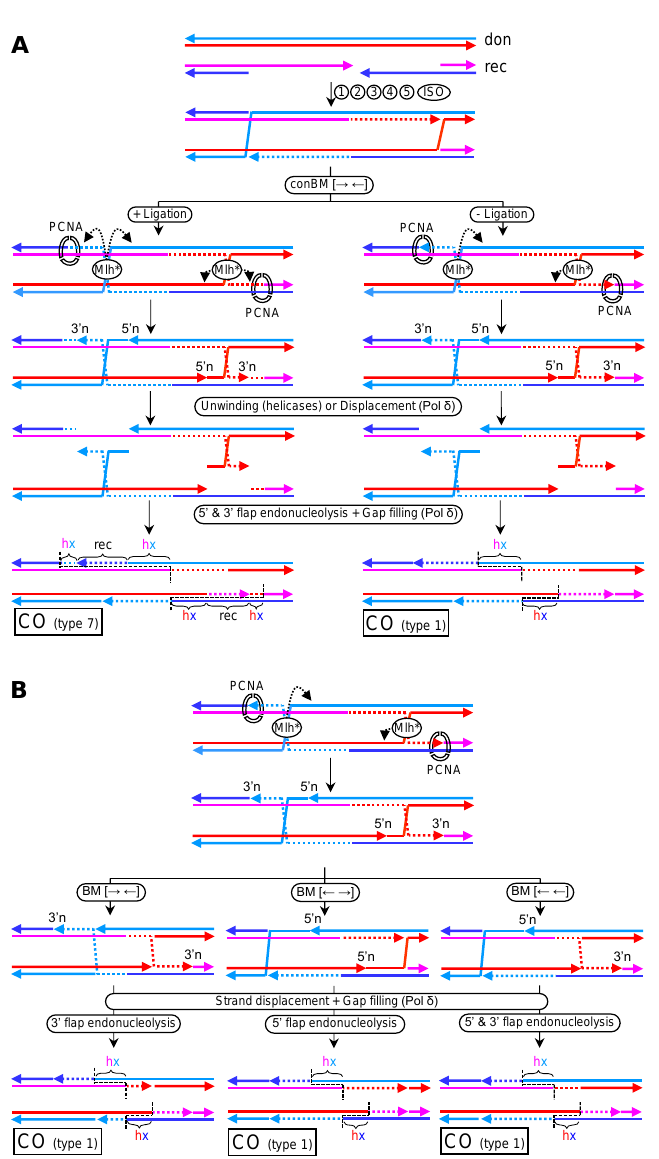
Figure 11. Models for ZMM meiotic resolution based on Mlh1-Mlh3 making incisions in cis upon a DPO dHJ. ( A ) Models in which cHJs are resolved from flanking nicks in the crossover strands. Steps 1–5 and ISO are like in Figure 10. Then, convergent branch migration is needed to relocate the newly synthesized tracts within the cross-joins, so that PCNA directs incisions into the crossover strands. Several mechanisms can then process each cHJ from the new nick located 5 (cid:48) to the cHJ (5 (cid:48) n). To ease visualization, two steps are depicted. Firstly, the unwinding and separation of the portion of nicked crossover strands that stretched across the cHJ, which resolves the cHJ into a 5 (cid:48) -flap and a 3 (cid:48) -flap. This can be achieved by the concerted actions of 3 (cid:48) → 5 (cid:48) and 5 (cid:48) → 3 (cid:48) helicases, or the displacement activity of Pol δ . Secondly, the resulting ssDNA gap is filled in by Pol δ , and the flaps are removed by specialized flap endonucleases. Note that strand displacement and gap filling occur in a single step when Pol δ commences resolution. If a DPO dcHJ is the substrate (left branch; + ligation), a double incision per cHJ is required. Because of the polarity of PCNA, the incision located 3 (cid:48) to the cHJ (3 (cid:48) n) ought to occur within the newly synthesized track. Thus, the genetic outcome is a reciprocal CO with a hx-recipient-hx tract (type 7). If a DPO dnHJ was the substrate before the converging migration (right branch; -ligation), only the 5 (cid:48) n incision is needed and the mandatory genetic outcome is a type 1 CO, since the 3 (cid:48) n coincides with the end of the HR-driven synthesis by Pol δ . ( B ) Variations of the right branch of A where branch migration towards one of the nicks precedes the action of Pol δ (or helicases; not depicted). Branch migration can be convergent towards the 5 (cid:48) ns (left branch), divergent towards the 3 (cid:48) ns (center) or codirectional (right branch). In all cases, DPO dnHJ are the intermediate metabolites and type 1 COs are the genetic